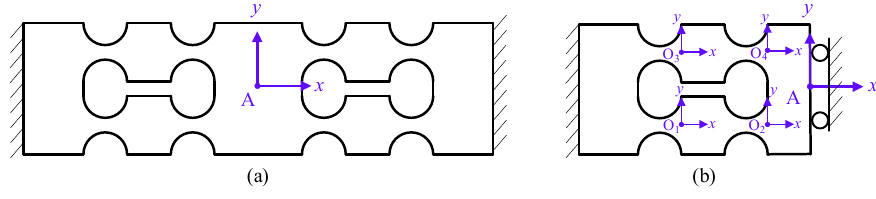
Figure 6. ( a ) DRCFH structure and ( b ) left half of the DRCFH structure.